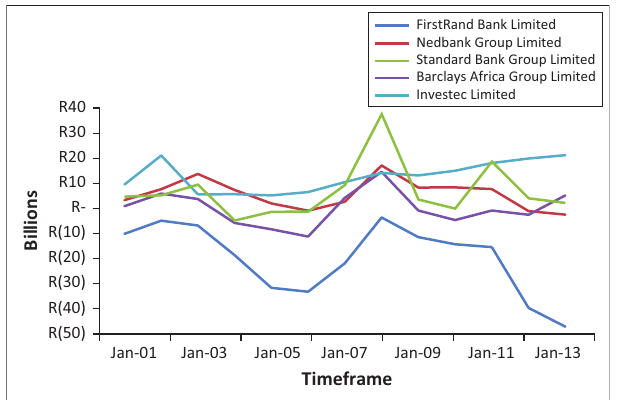
FIGURE 2: Systemic risk index of each South African bank.